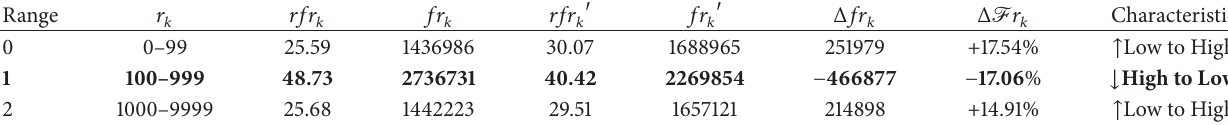
Table 16: Characterization of malicious update attacks on range of data values.